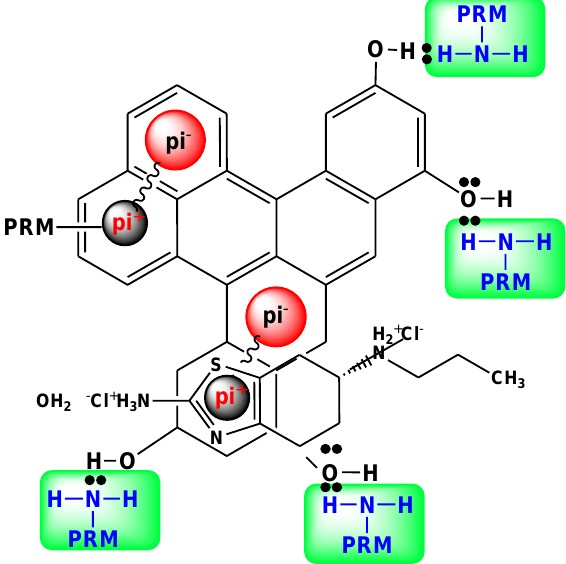
Figure 6. Possible interactions between PRM molecules and activated carbons (ACs).